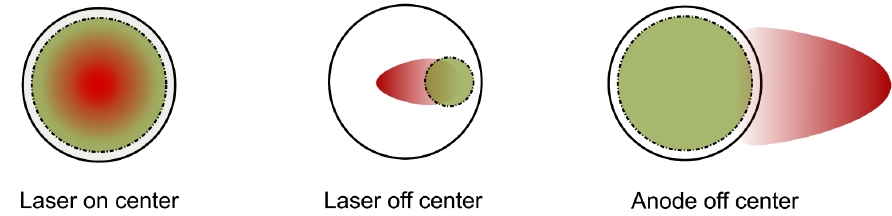
FIG. 2. Laser spot size and expected damage profiles for various operation schemes. The green area indicates damage from low energy ions and the red area indicates damage from medium-high energy ions. Increasing intensity of the red section represents increasing energy. The solid and dashed circles respectively indicate total cathode area and laser spot